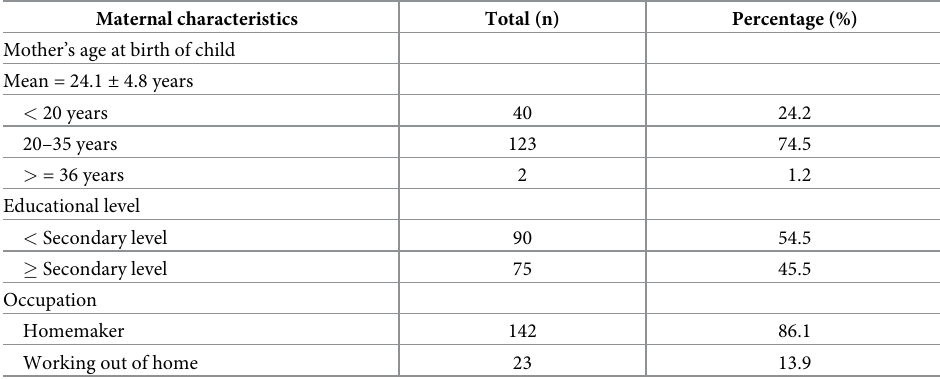
Table 2. Maternal characteristics.